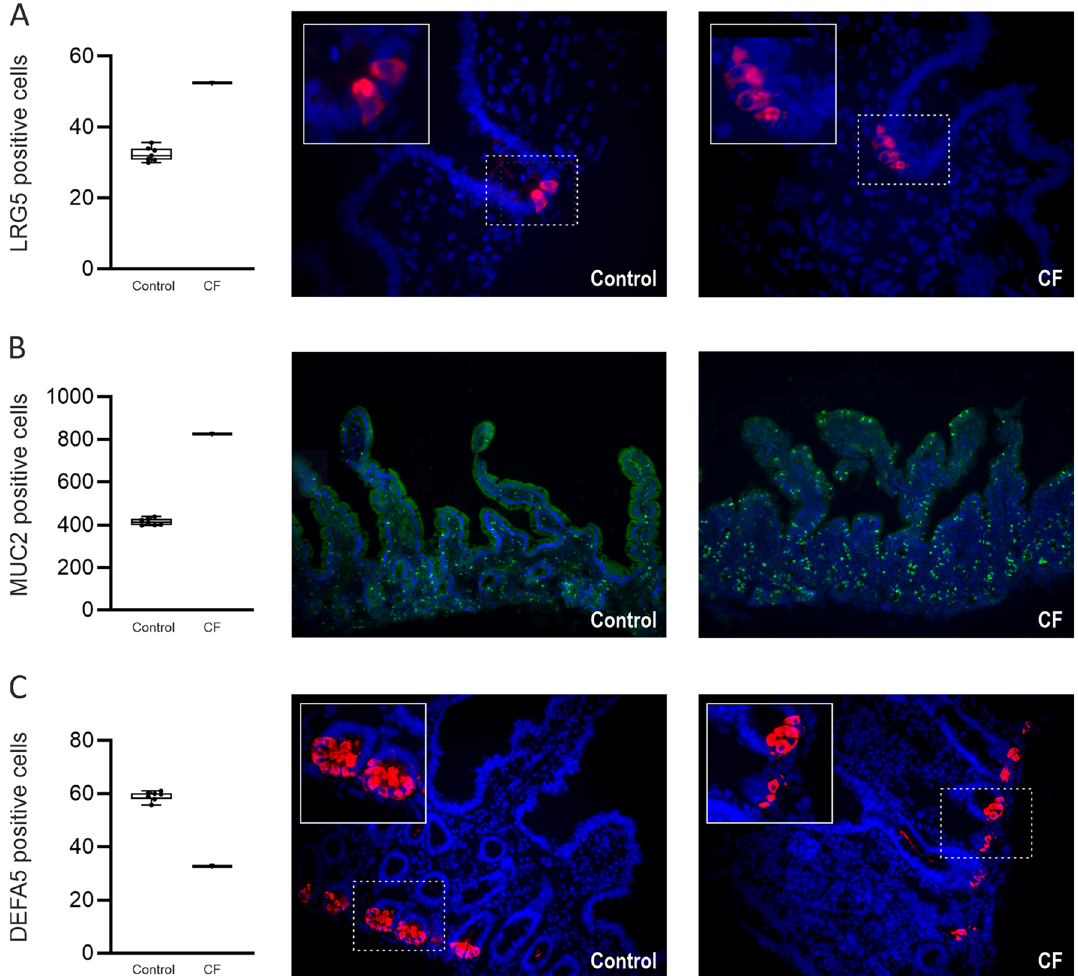
Figure 6. Expression of stem, goblet and Paneth cells in human ileal tissues from one patient with CF and seven non-CF controls. Quantification of cell numbers and representative images of ( A ) stem cells (leucine-rich repeat-containing G-protein coupled receptor 5, LRG5) positive cells stained red; ( B ) goblet cells (mucin-2, MUC2) positive cells stained green and ( C ) Paneth cells (defensin 5, DEFA5) positive cells, stained red. Nuclei are stained blue with 4 ʹ , 6-diamidino-2-phenylindole (DAPI). Box and whisker plots represent total number of cells counted expressing LRG5, MUC2 and DEFA5 as median ± 95% CI. The insets enclosed in white boxes show higher magnification of the areas enclosed by the dashed lines. Images are 400 × ( A ), and 100 × ( B) & 200 × ( C )